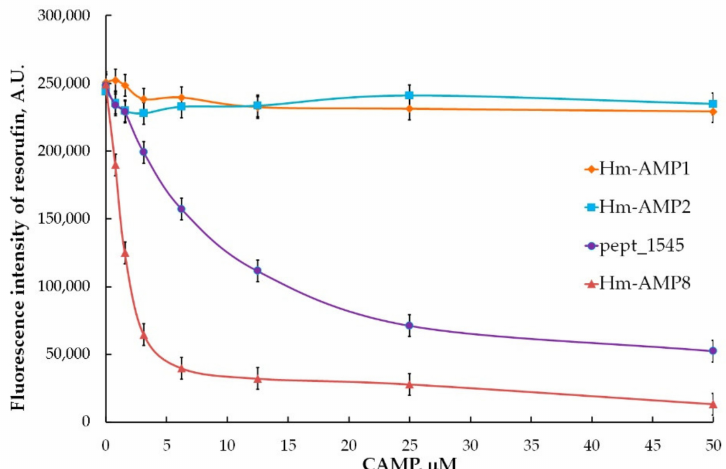
Figure 5. MPO peroxidase activity towards Amplex Red and H 2 O 2 in the presence of the cationic an- timicrobial peptides Hm-AMP1, Hm-AMP2, pept_1545, and Hm-AMP8 at 0.8–50 µ M (peptide/heme molar ratio from 100 to 6250). The concentrations were as follows: 8 nM MPO heme, 50 µ M Amplex Red, and 25 µ M H 2 O 2 in 50 mM K-phosphate buffer, pH